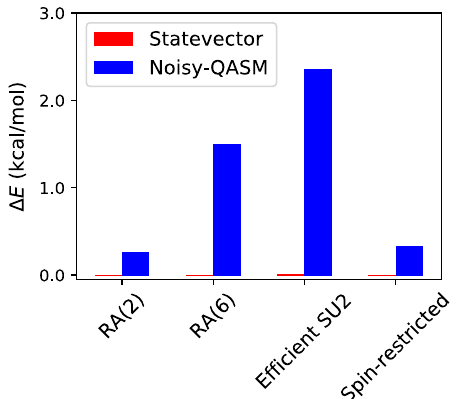
Fig. 4 Comparison of ansätze for the ground state calculation of ethylene. The energy deviations Δ E (in kcal mol − 1 ) from the exact values were calculated at the FC geometry using SS-CASSCF with statevector (in red) and noisy-QASM simulators (in blue). Detailed values are shown in Supplementary Table 1.